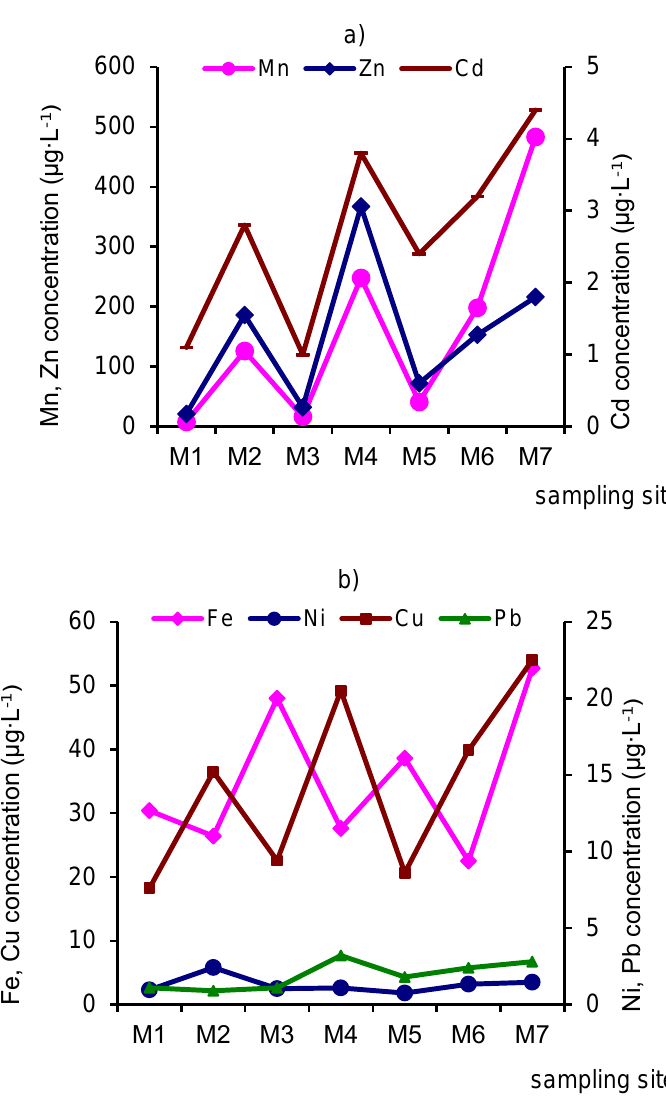
Figure5. VariationofthedissolvedMn, Zn, Cd( a ), Fe, Ni, Cu, Pb( b Figure 5. Variation of the dissolved Mn, Zn, Cd ( a ), Fe, Ni, Cu, Pb ( b ) concentrations in the sampling sites.